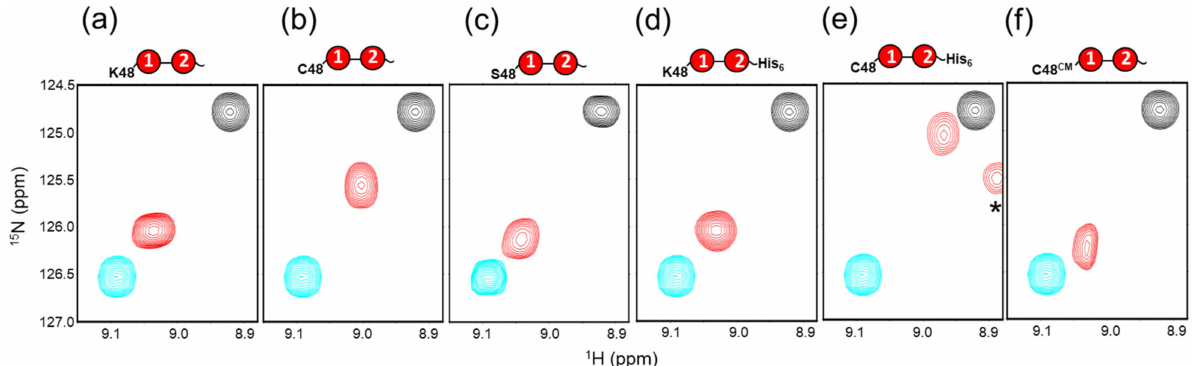
Figure 2. Effects of substitution of Lys48 of the distal Ub unit of diUb. 1 H- 15 N HSQC peaks originating from Val70 of uniformly 15 N-labeled ( a ) wild-type diUb, ( b ) K48C-diUb, ( c ) K48S-diUb, ( d ) wild-type diUb-His 6 , ( e ) K48C-diUb-His 6 , and ( f ) K48C CM -diUb are shown in red. The peaks from monomeric Ub and c-diUb are shown in cyan and black, respectively. The spectra were measured at 25 ◦ C in 10 mM sodium phosphate buffer, pH 7.0. Asterisk indicates a peak originating from Phe45 of the distal Ub